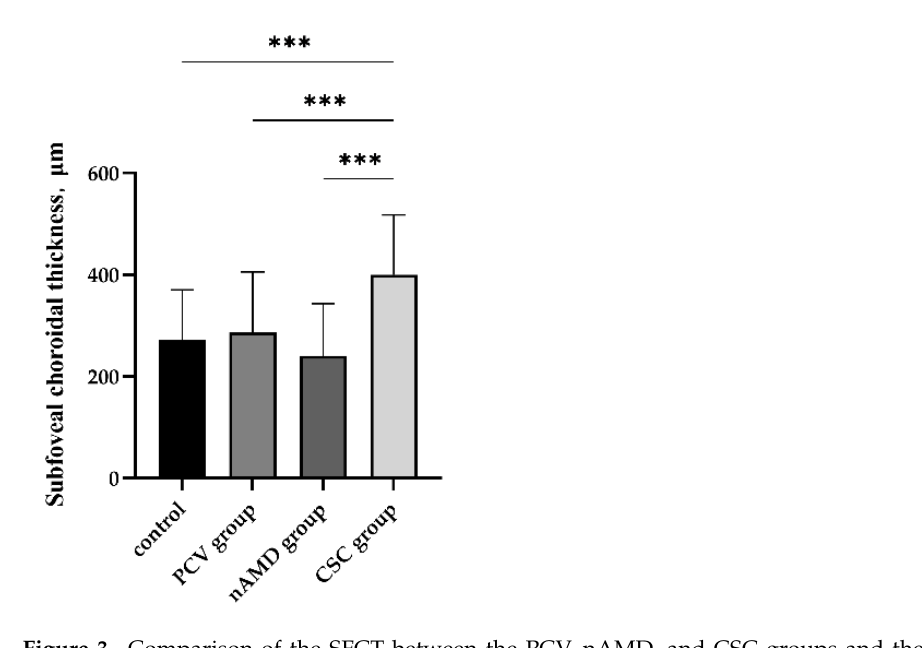
Figure 3. Comparison of the SFCT between the PCV, nAMD, and CSC groups and the normal control group. PCV: polypoidal choroidal vasculopathy; nAMD: neovascular age-related macular degeneration; CSC: central serous chorioretinopathy. *** p < 0.001.